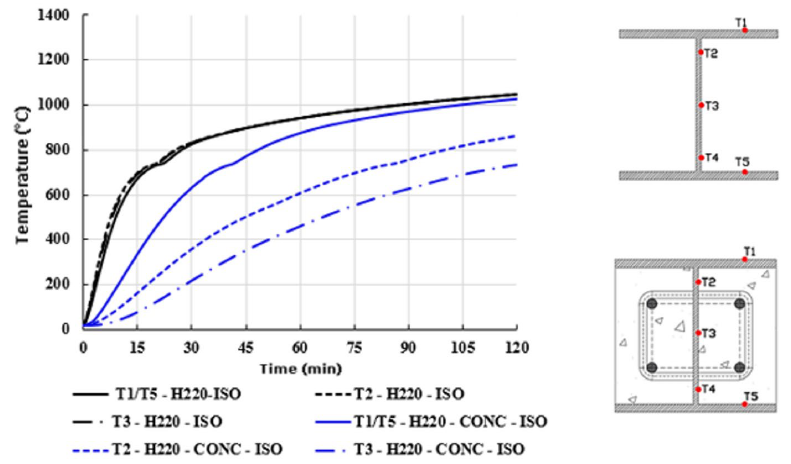
Figure 6. “Temperature vs time” curve for steel and composite H220-ISO